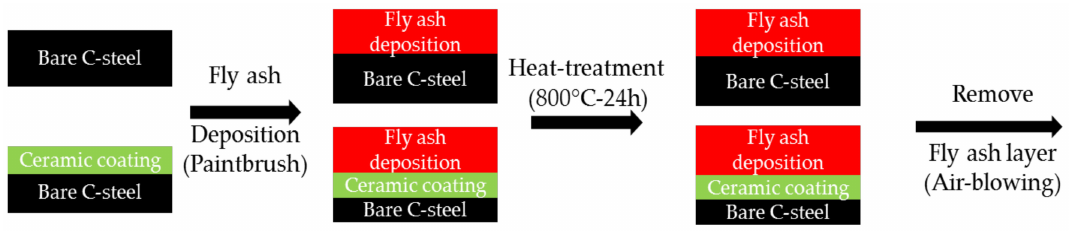
Figure 1. Anti-fouling resistance testing